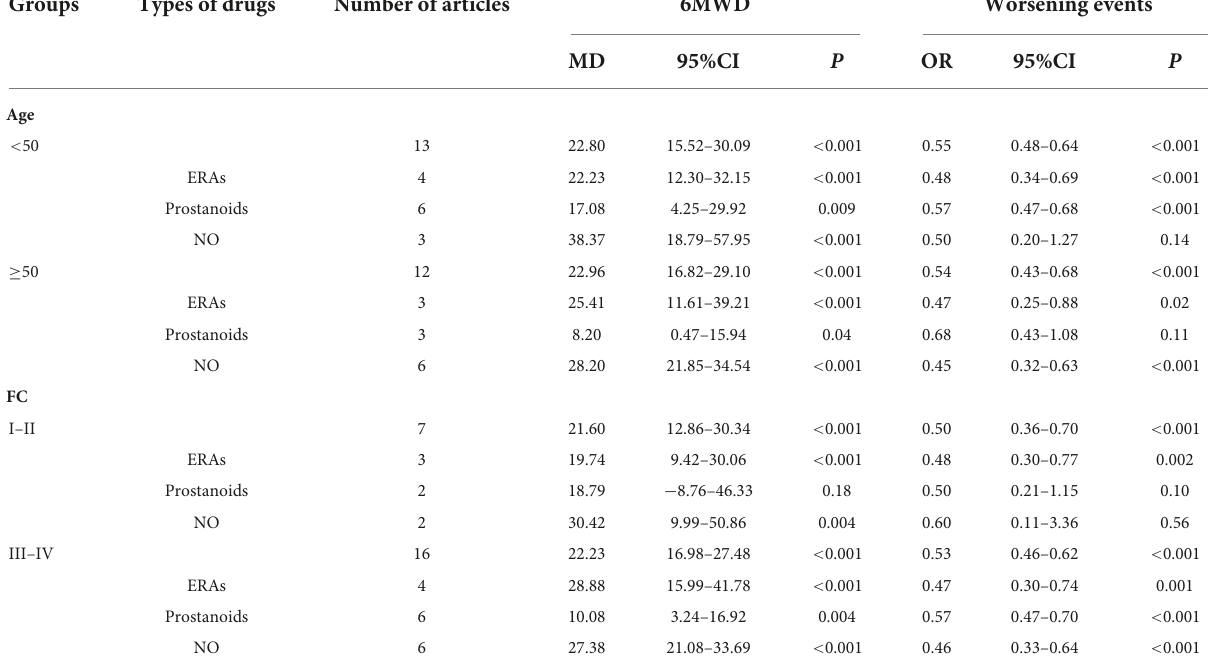
TABLE 5 Subgroup meta-analysis based on age and functional class (FC)